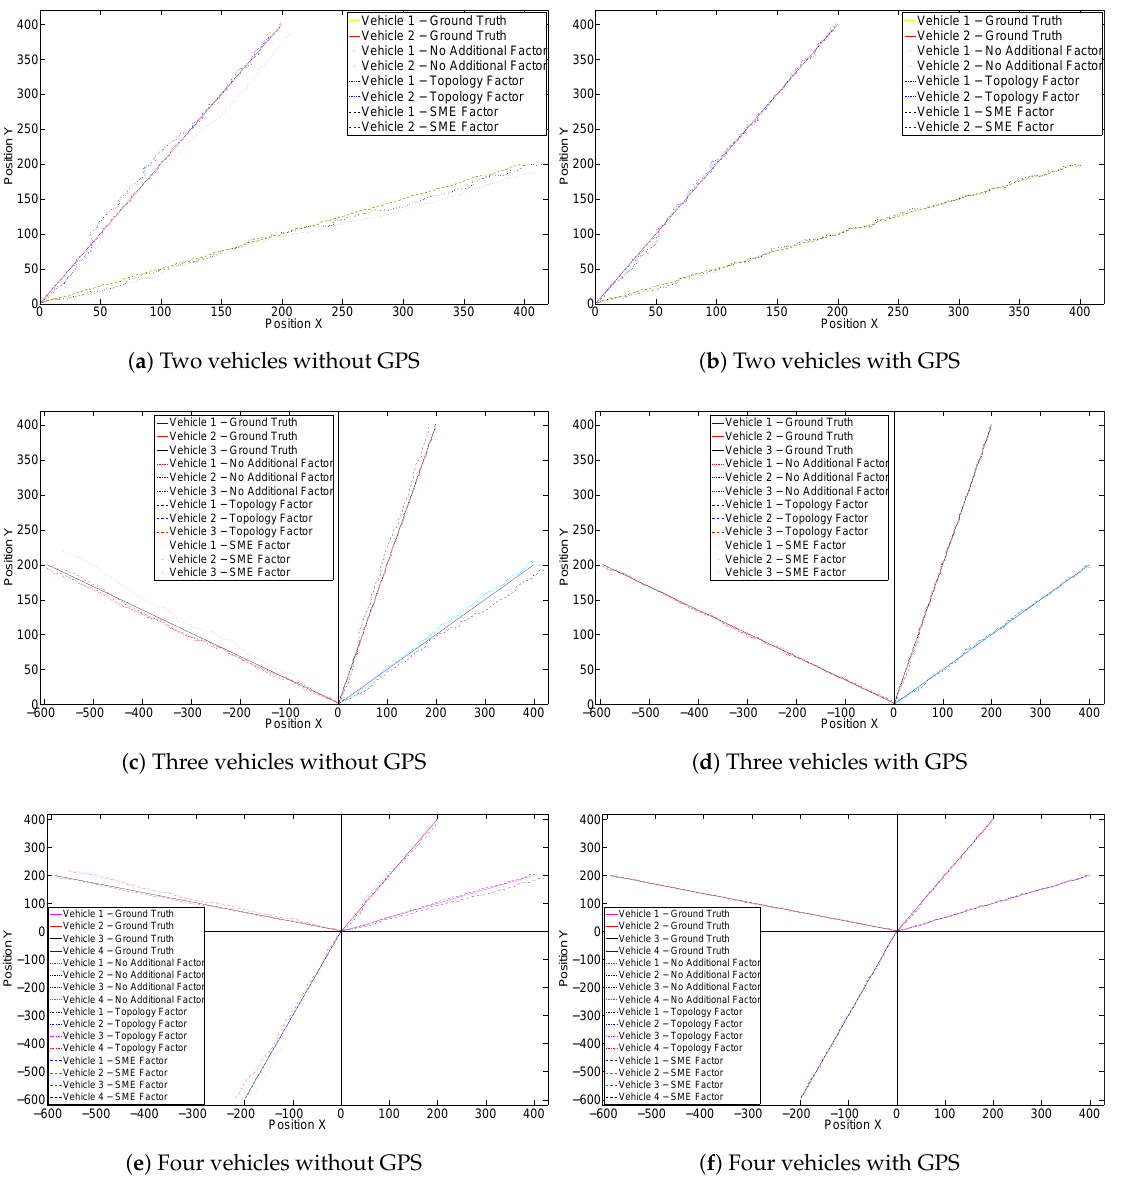
Figure 10. One iteration of ground truth and fused trajectories for 2-, 3- and 4-vehicle systems for Monte Carlo simulation of 1000